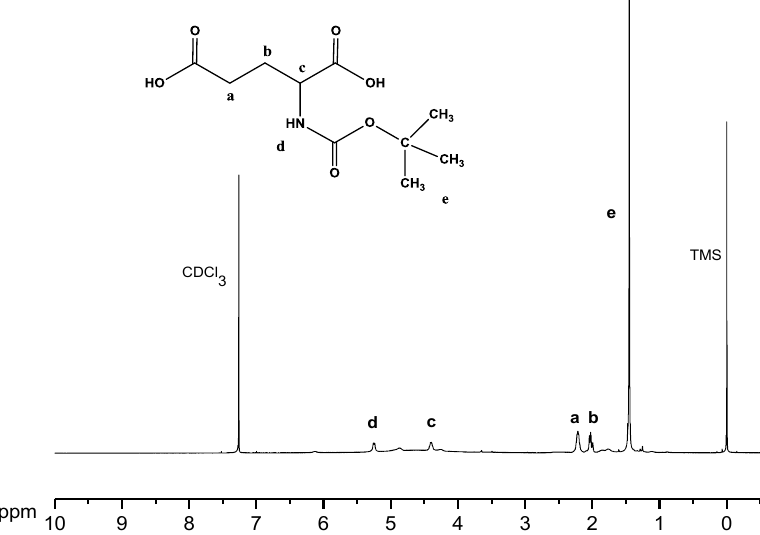
Figure 1. 1 H-NMR spectrum of N -Boc glutamic